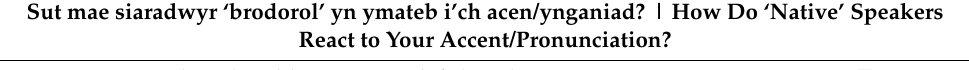
Table A3. ‘native’ speaker reaction to accent and pronunciation item in the questionnaire.